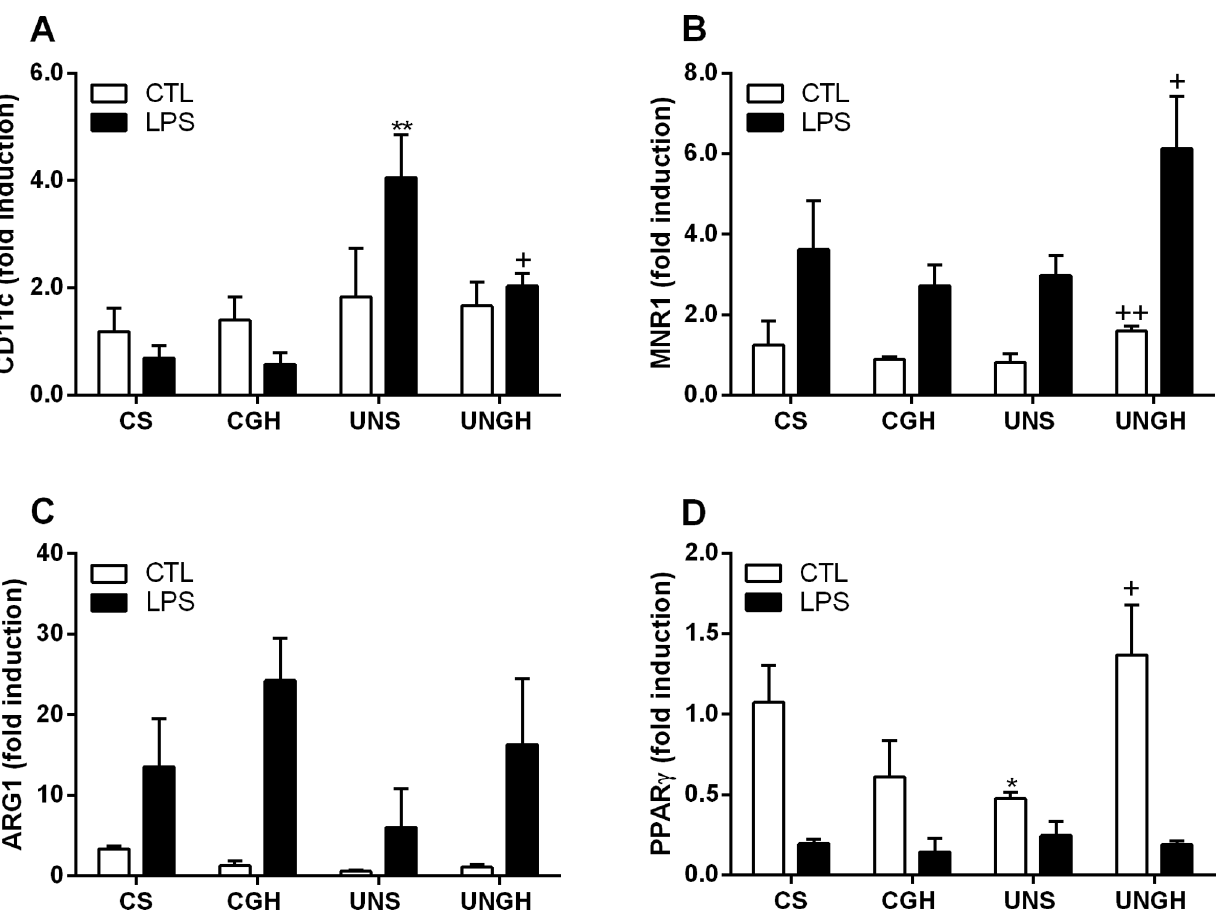
Figure 4. Macrophage polarisation gene expression. Bone marrow was isolated from CS, CGH, UNS and UNGH male adult rats. Cells were cultured for 7 d in the presence of M-CSF (50 ng/ml) to differentiate to BMM. Once differentiated, BMM were stimulated for 6 h with LPS (100 ng/ml). Gene expression of (A) CD11c, (B) MNR1, (C) ARG1 and (D) PPAR c were analysed by RT-PCR. (*p , 0.05, **p , 0.01 w.r.t CS; + p , 0.05, ++ p , 0.01 w.r.t UNS, n=4). Values were expressed as mean 6 SEM.